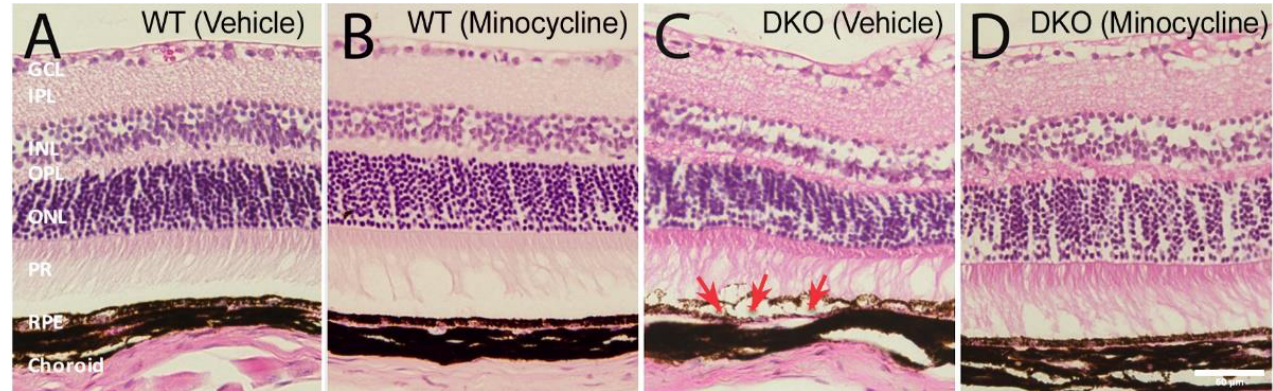
Figure 8. The effect of minocycline on retinal structure in histological examination. Representative images of hematoxylin and eosin (H&E) stained retinal sections from vehicle-treated wild type (WT) ( A ), minocycline-treated WT ( B ), vehicle-treated double knockout (DKO) ( C ) and minocycline-treated DKO mice ( D ). Arrows in ( C ) indicating RPE swelling and vacuoles. GCL: ganglion cell layer; IPL: inner plexiform layer; INL: inner nuclear layer; OPL: outer plexiform layer; ONL: outer nuclear layer; PR: photoreceptor segments; RPE: retinal pigment epithelium. Scale bar = 50 μm.